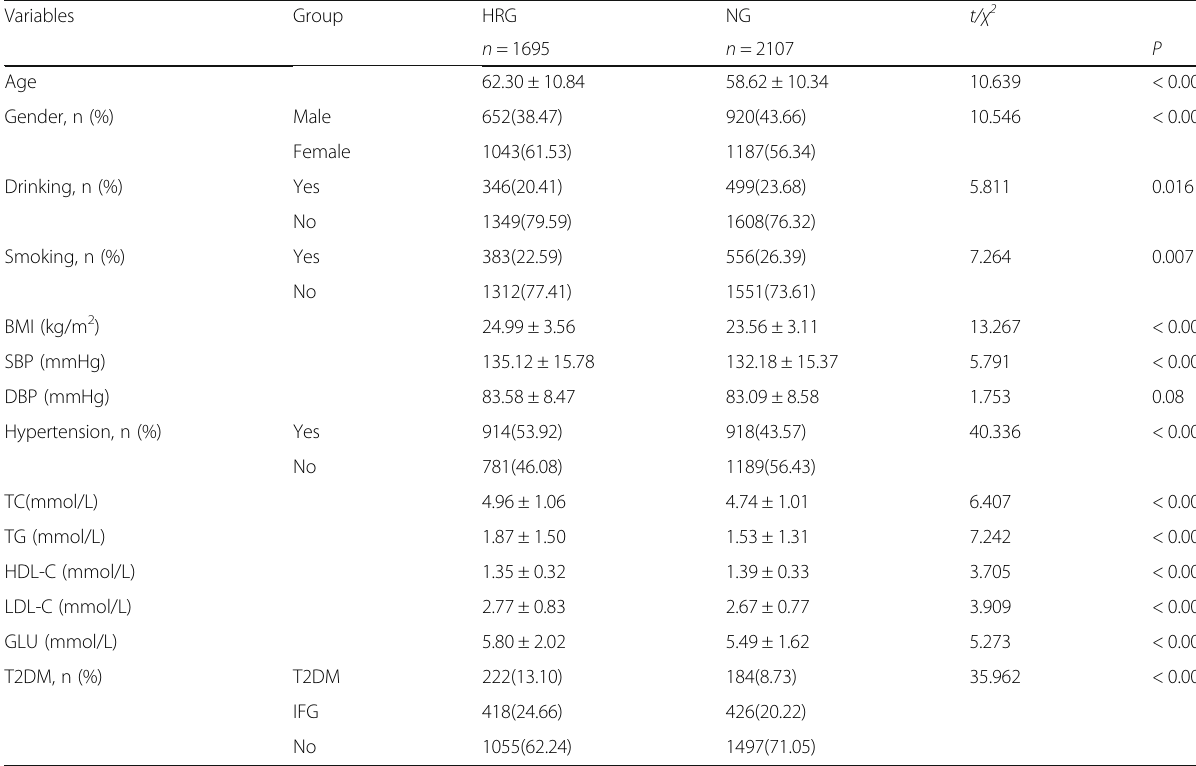
Table 1 Baseline characteristics for different hs-CRP groups